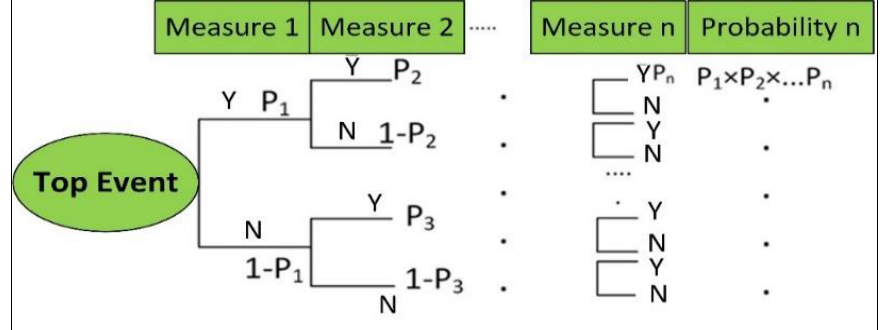
Figure 4: Structure of